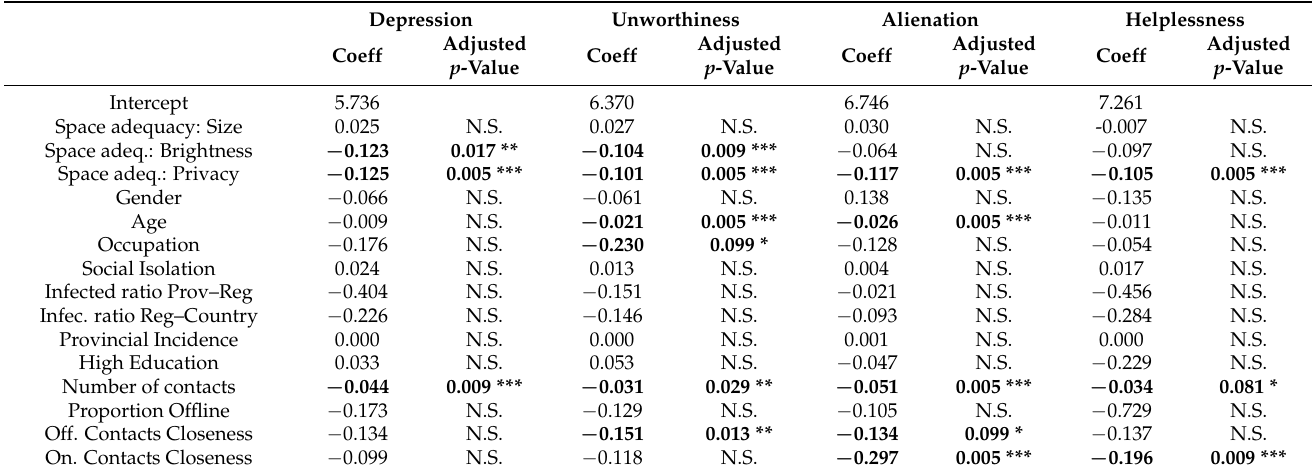
Table 2. Estimates and adjusted p -values of the partial permutation tests on the regression coefficients of the multivariate regression model (significant estimates in bold).